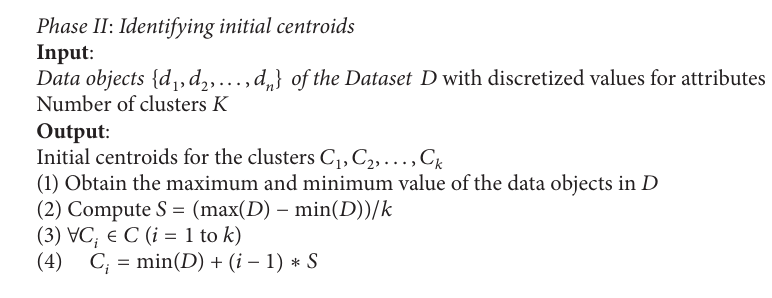
Algorithm 2: Identifying initial centroids.